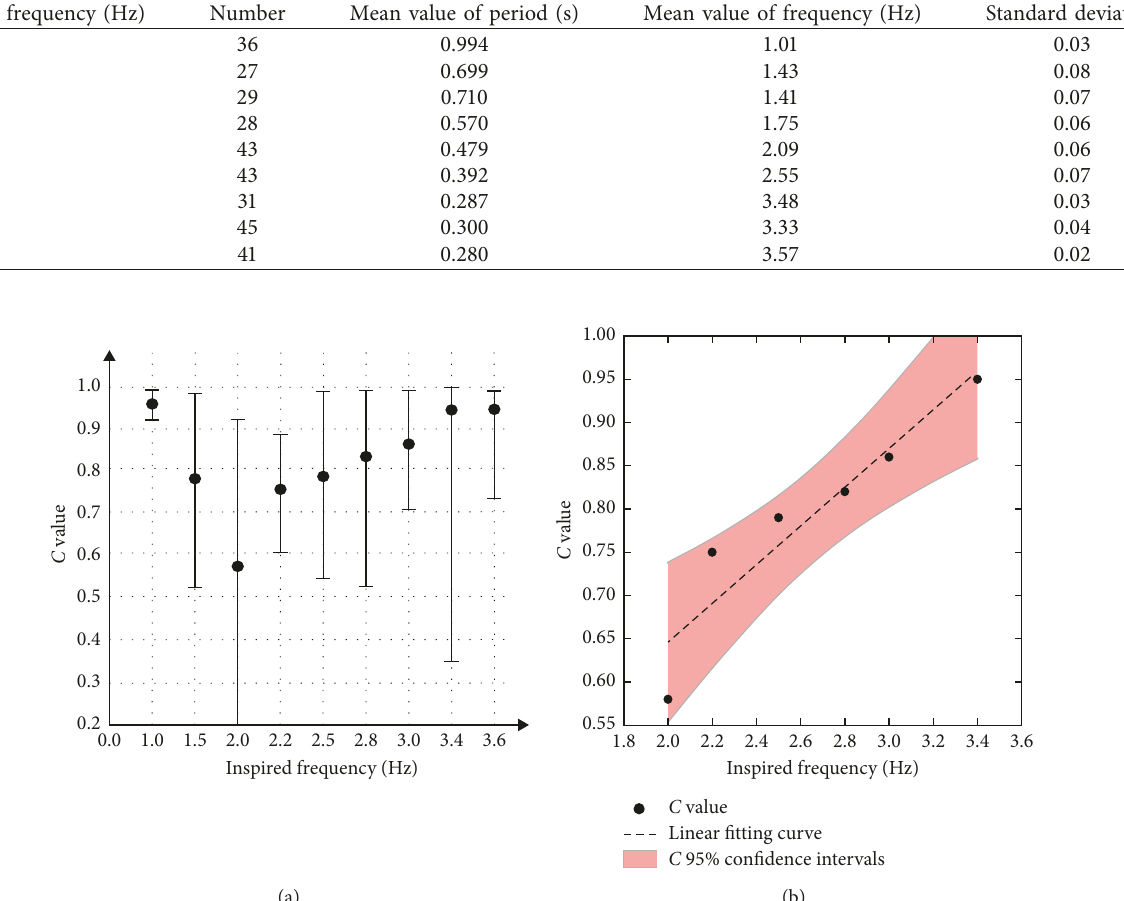
Figure 9: The relationship between inspired frequency and C value. (a) Analysis of crowd swaying synchronization and (b) the linear fitting curve.